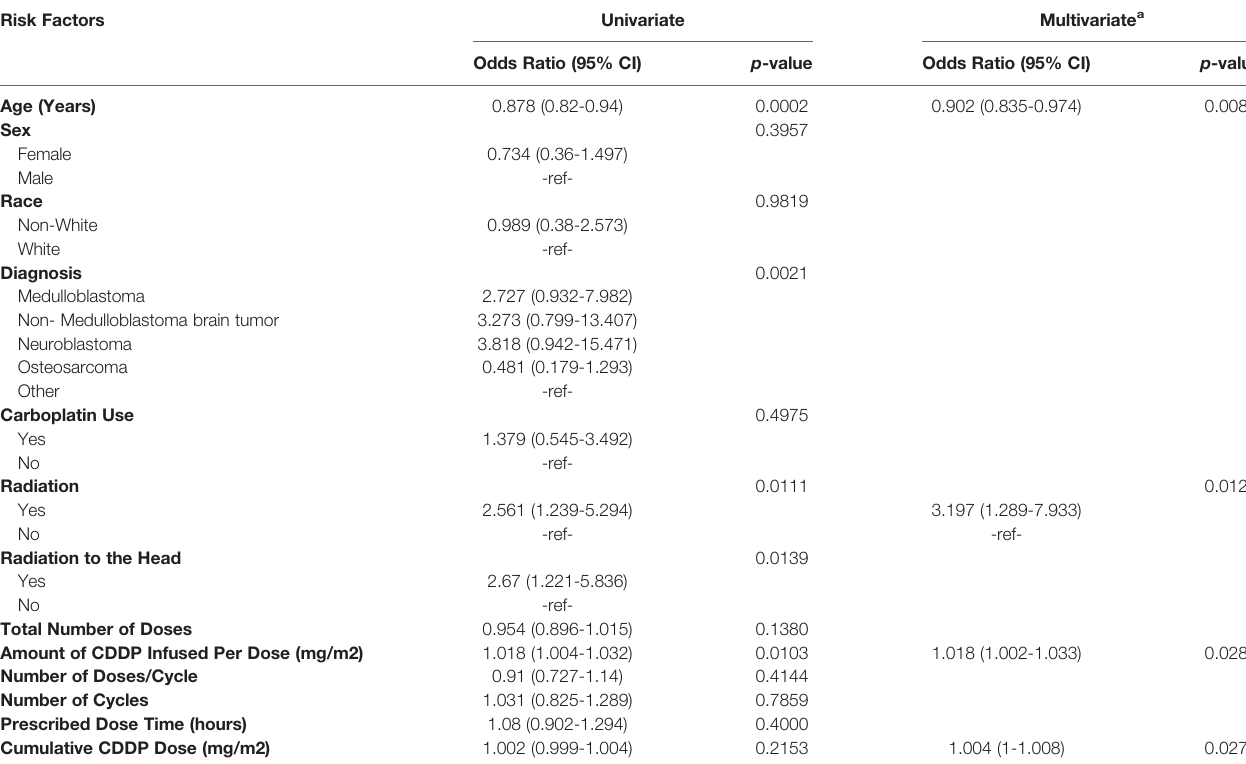
TABLE 2 | Univariate and multivariate binary logistic regression sasessing risk factors for the presence of hearing loss. Risk